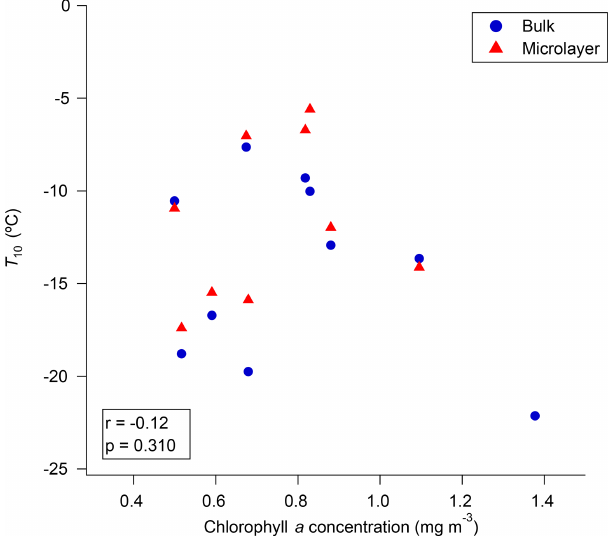
Figure 7. Relationship between satellite-derived chlorophyll a con- centrations and the T 10 values of microlayer and bulk seawater for 2016. Only freezing data that were at warmer temperatures than the field blanks are